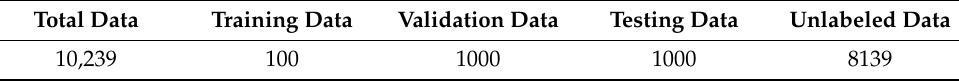
Table 6. Training/validation/testing/unlabeled separation statistics (CNN, HCI-HAR).